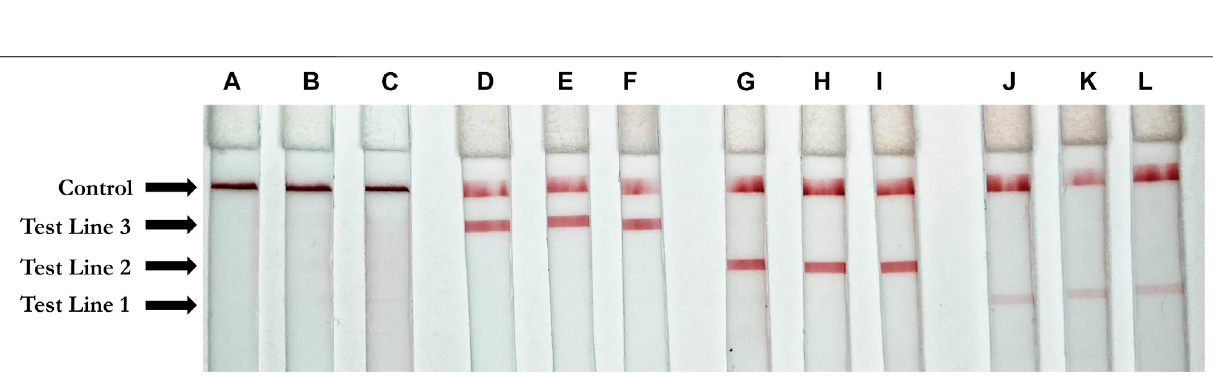
FIGURE 3 | Demonstrative colorimetric loop-mediated isothermal reaction using primers as listed in Table 1 . Viral RNA from SARS-CoV-2 (ATCC) were spiked in the amounts of 0, 3, 5, 10, 25, 100, and 1,000 RNA copies per microwell and reactions were imaged after 15 and 30 min, respectively.